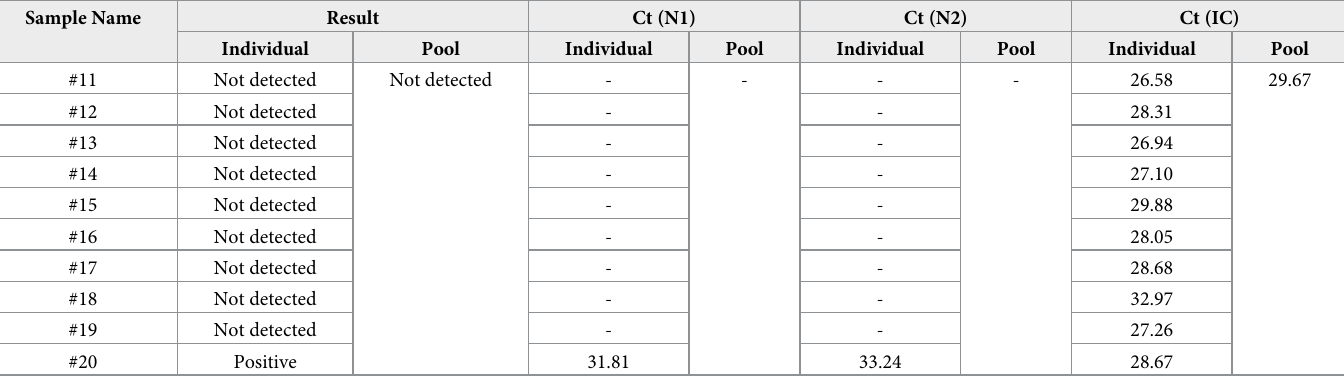
Table 2. Individual amplification of 10 samples from the pool including positive case 2 (#20).